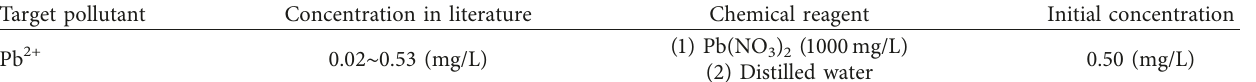
Table 3: Preparation of synthetic rainwater for this study.